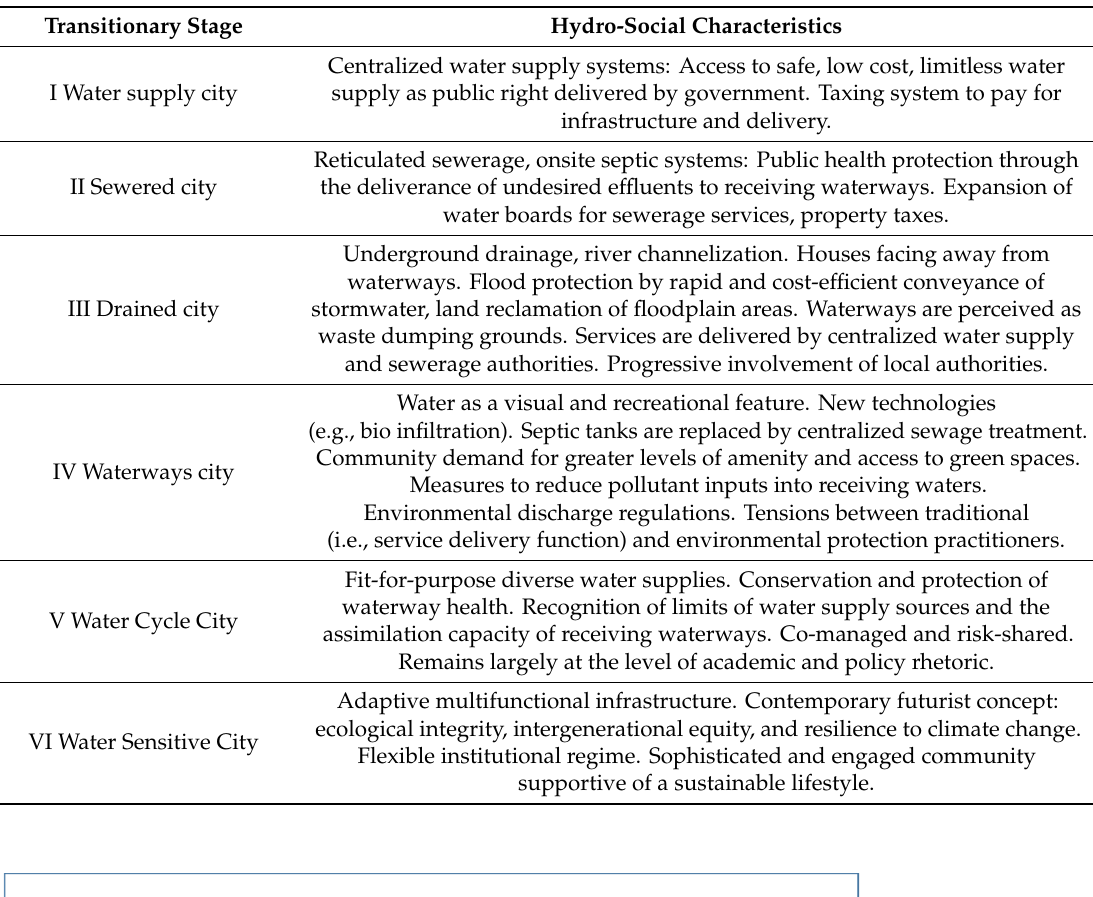
Table 1. Urban Water Transitions Framework (adapted from [8]).